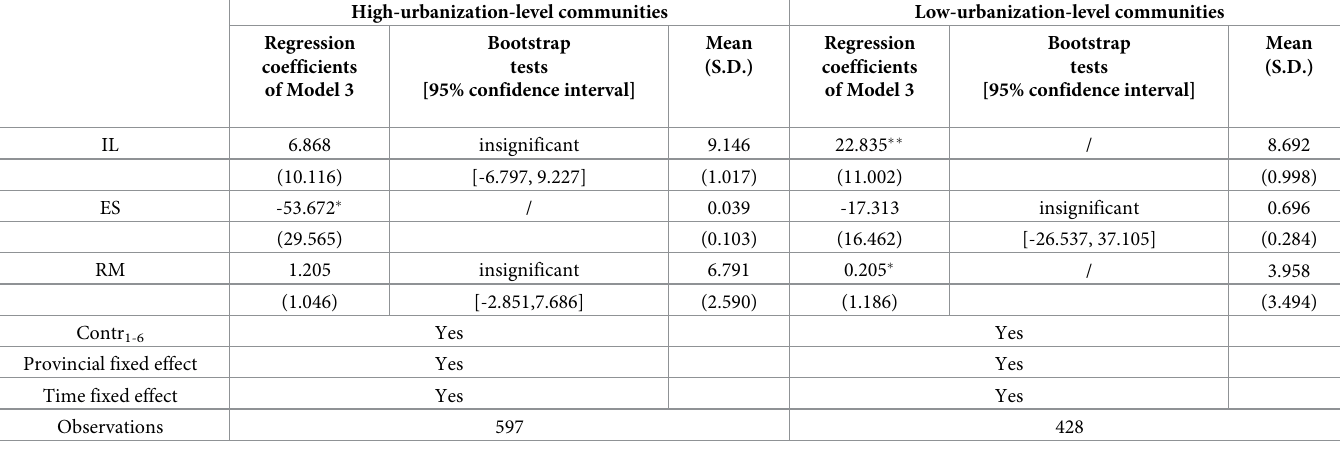
Table 5. The regression and bootstrap test results of the mediating effects in different urbanization level groups a